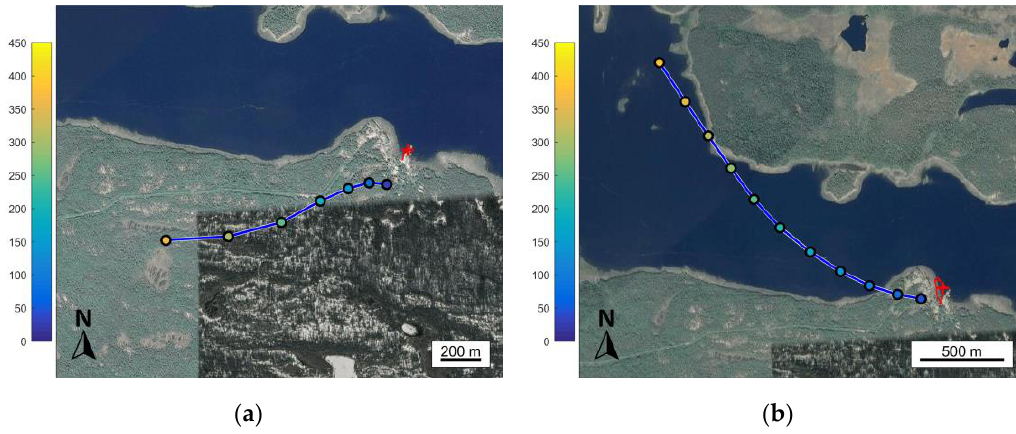
Figure 10. Example of the balloon’s trajectories at 29th of January ( a ) and 1st of February ( b ). White line with colored markers indicates the balloon’s trajectory within the lowest 500 m (height is shown by color) and read “+” symbol indicates the location where drone-based sounding was performed. Google maps images are used as background. Presented cases at ( a ) and ( b ) plots corresponds to wind profiles shown in Figure 5b, e and Figure 5c, f respectively.